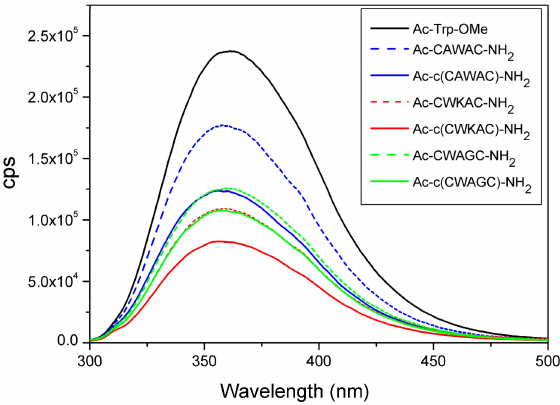
Figure 6. Trp-fluorescence measurements of linear and cyclic peptide models. Emission spectra were measured at λ ex = 280